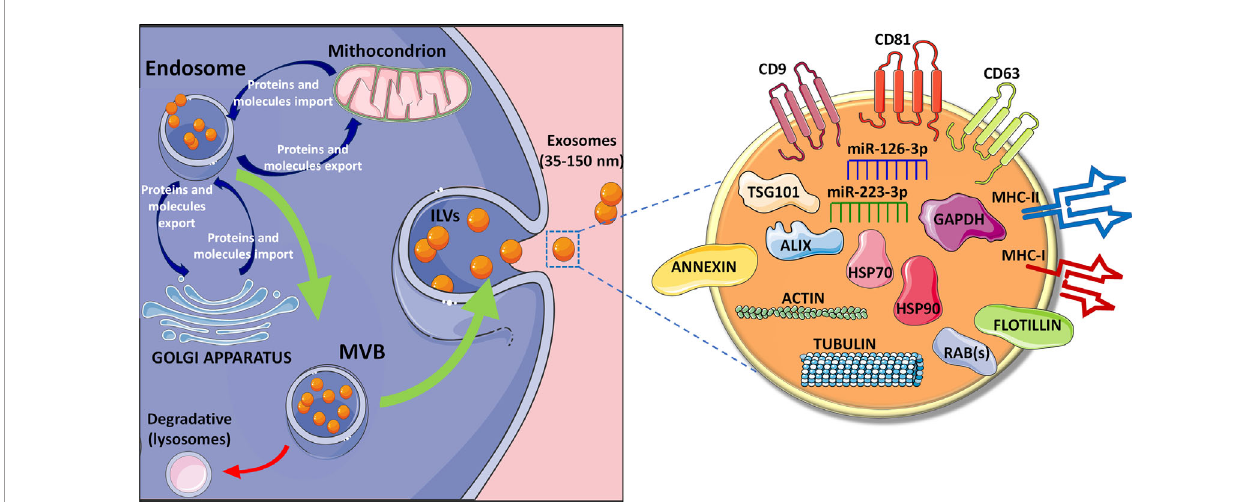
FIGURE 1 | Exosomes biogenesis and composition. Exosomes biogenesis is based on a process of double invagination of the plasma membrane. The fi rst step leading to the invagination process results into de novo formation of an early-sorting endosome characterized by cell-surface proteins and soluble proteins. Following the continuous exchange (import and export) of speci fi c proteins and molecules from endosomes and mitochondria as well as with Trans Golgi network, the early- sorting endosome can mature into a late-sorting endosome through a second invagination of the plasma membrane leading to the generation of the Multi Vesicular Bodies (MVBs) composed by multiple intraluminal vesicles (ILVs). Then, MVBs can: ( i ) fuse with lysosomes resulting in the digestion of their ILVs or ( ii ) fuse with the plasma membrane thus leading to the release of ILVs as exosomes (22, 23). Exosomes expose several membrane proteins, such as tetraspanins (CD9, CD81, CD63) (24 – 28) and MHC molecules, both class I and class II, as well as Annexin and Flotillin. Moreover, exosomes content is highly variable depending on the cell of origin, but usually they contain cytoskeleton proteins (e.g., actin and tubulin), heat shock proteins such as HSP70 and HSP90, proteins associated to metabolism (GAPDH) (29 – 31), as well as speci fi c proteins (e.g., ALIX, TSG101 and RAB proteins). Exosomes also contains different RNA species such as microRNAs, among which the most reported are miR-126-3p and miR-223-3p (32 –